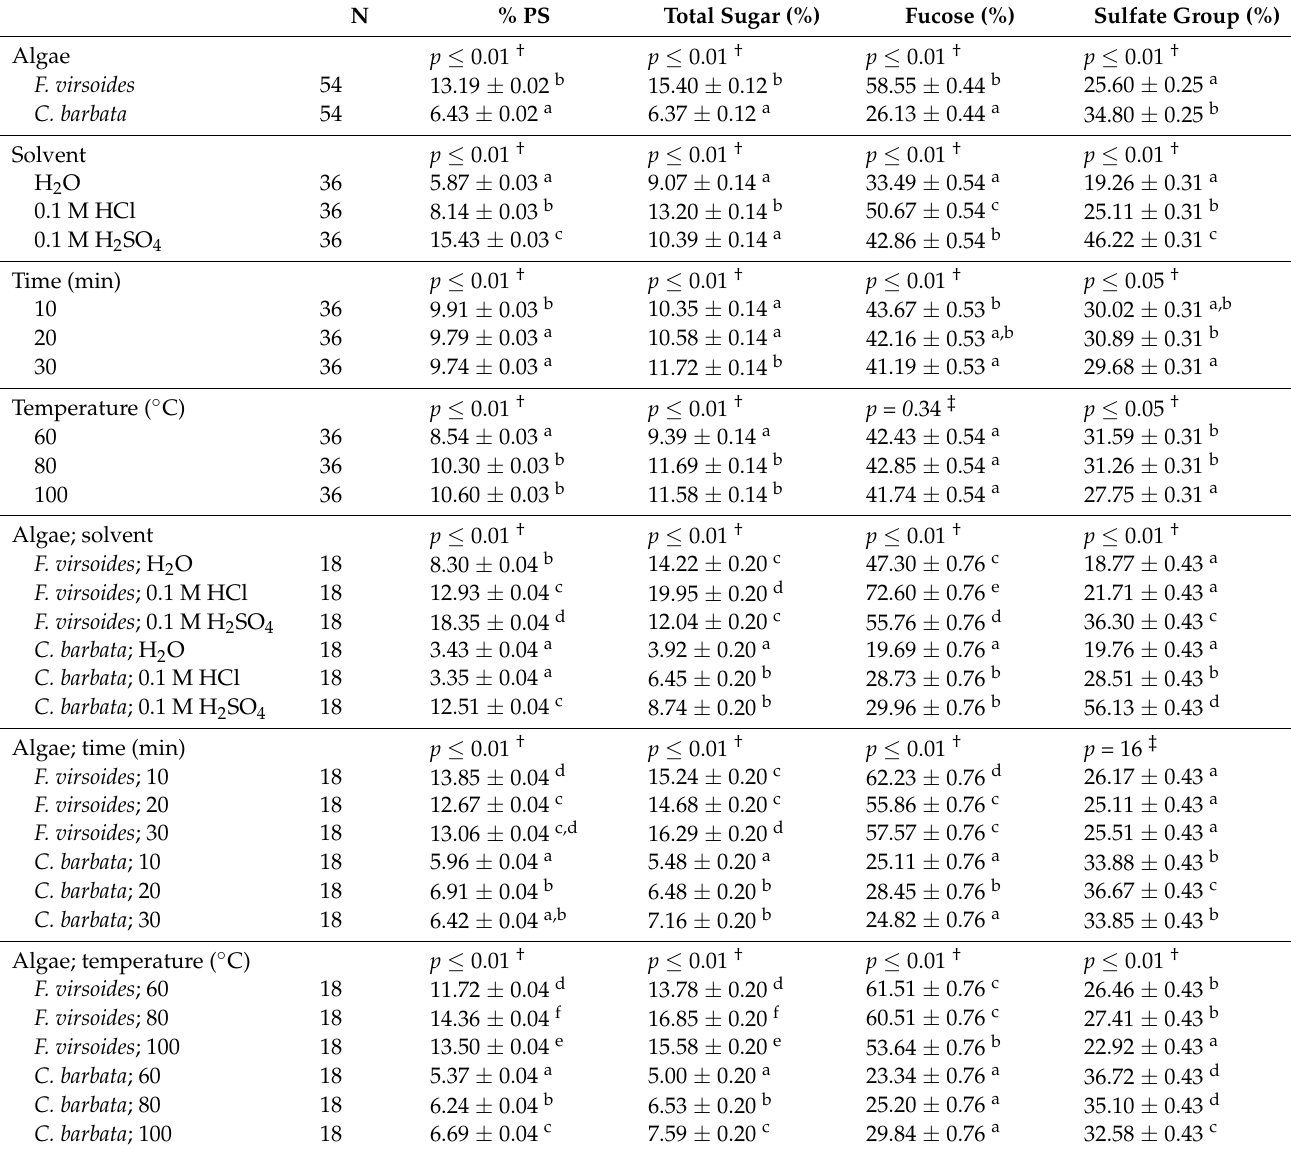
Table 2. Influence of algae species ( F. virsoides and C. barbata ), extraction solvent (water, 0.1 M HCl, and 0.1 M H 2 SO 4 ), time (10, 20, and 30 min), and temperature (60, 80, 100 ◦ C) in microwave assisted extraction on the yield (%PS) and chemical composition of the extracted